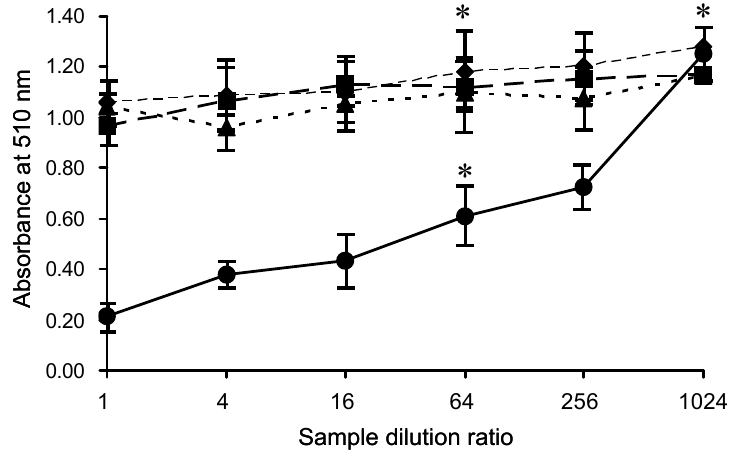
Figure 3. Effects of lectins on SLO-induced hemolysis. RBCs were pre-mixed with serially diluted lectins (AKL: solid line; ECA: dotted line; ABA: small dashed line; PNA: large dashed line). SLO was added to each sample, mixed with HCL/acetone, and inhibition of hemolysis was assessed by measurement of absorbance at 510 nm as in Figure 2. Error bars: SE from three independent experiments. * p < 0.01 in comparison with negative control.